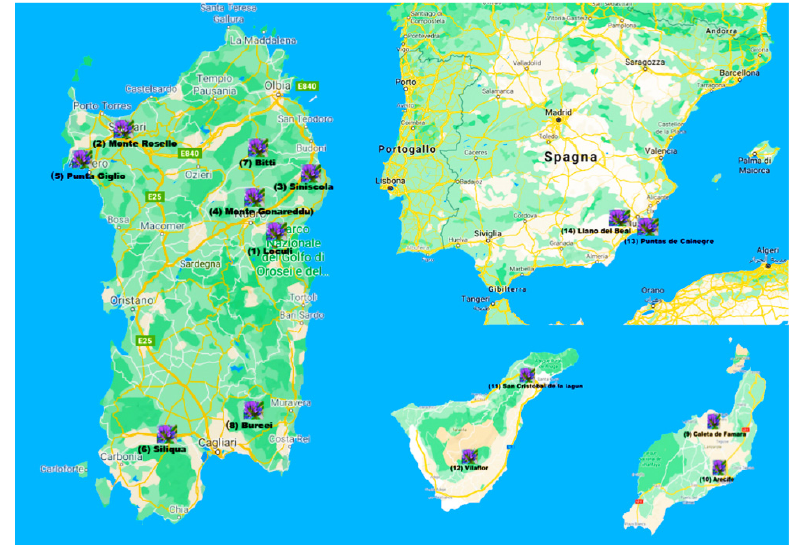
Figure 4. Collecting stations for accessions of Sardinian and Spanish Bituminaria plants. The species located in Canary Islands showed a large diversity, with three botanical varieties found in habitats ranging from the coastal semiarid areas on Lanzarote Island with an annual rainfall of 150–300 mm ( B. b. var. albomarginata ) to the high elevation sub- humid area (1700–2200 m, 500 mm) of Tenerife ( B. b. var. crassiuscula ). The third ( B. b. var. bituminosa ) displayed a wide adaptation across the Canary Islands (300–1000 m) and is the only one present in the Mediterranean basin. In the Iberian Peninsula, it has been found in environments ranging from 250–1000 mm of rainfall and up to 1250–1500 m of altitude